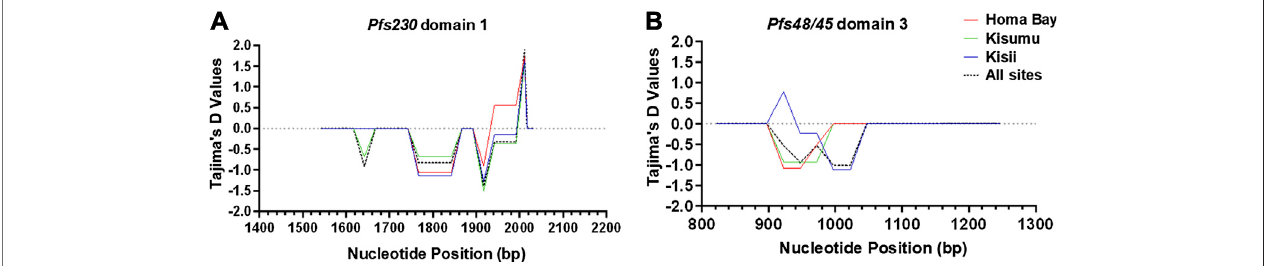
FIGURE 3 | Sliding window plot of Tajima ’ s D values for Pfs230 domain one and Pfs48/45 domain three in western Kenya. The X -axis displays the nucleotide position(Windowmidpoint)whereastheTajima ’ s D valuesarerepresentedonthe Y -axis. (A) isarepresentationof Pfs230 domain onewhereas (B) representsof Pfs48/ 45 domain3.ThebluecurverepresentscomputedTajima ’ s D plotforsequencesof P.falciparum circulatinginKisii,theredcolourisforHomaBay,thegreencolourisfor Kisumu(Chulaimbo)whereastheblackdottedcolourrepresents thepopulation fromthethreestudysites.Themiddlehorizontaldottedline(intersectingthe Y -axis at 0.0) represents a standard neutral model where the Tajima ’ s D value isequal to zero. Positive deviation from the grey dotted line signi fi esbalancing selection whereas negative deviation represents purifying